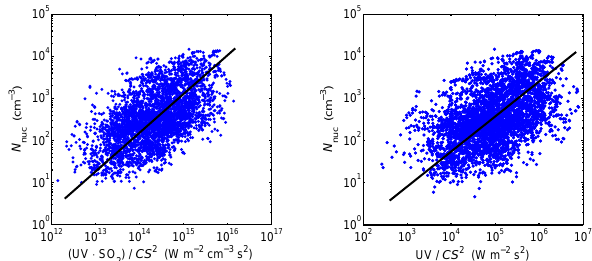
Table 1. Mean, median and percentiles (10th and 90th) for the measured data set used in the comparison of proxy performance in Hyyti¨al¨a. Measured nucleation mode particle concentrations N nuc were compared to Eq. (9) (proxy utilizing UVB, SO 2 , CS and AOD). The comparisons are shown in Figs. 1 and 2. In the compar- isons data was averaged to 30 min time resolution. 10th 90th mean median percentile percentile Fig. 1. Measured number concentration of nucleation mode par- ticles ( N nuc , diameter 3–25nm) as a function of the proxy given by Eq. (9) (left) and the same proxy with SO 2 concentration left out (right). Each data point represents 30 min averaged data. The black lines show linear least-squares fit to the data points. Left: log( y) = 0 . 92 × log( x) − 10 . 69 ( r = 0 . 54, p < 0 . 001); Right: log( y) = 0 . 83 × log (x) − 1 . 58 ( r = 0 . 49, p < 0 .